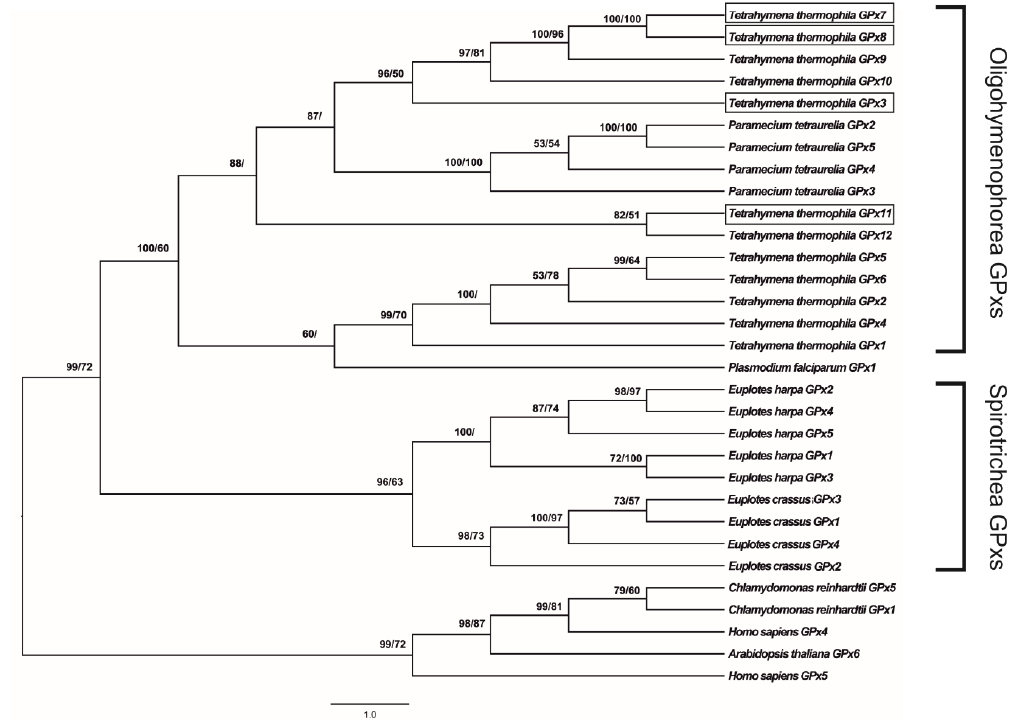
Figure 2. Phylogenetic relationships among glutathione peroxidases (GPxs) of various organisms reconstructed on the basis of the cDNA coding region sequences and using both Bayesian interference (BI) and maximum likelihood (ML) methods. Bayesian posterior probability (first number) and bootstrap values higher than 50% are indicated on each node, respectively. The scale for branch length (1.0 substitution/site) is shown below the tree. T. thermophila GPx3, GPx7, GPx8 and GPx11 are boxed.